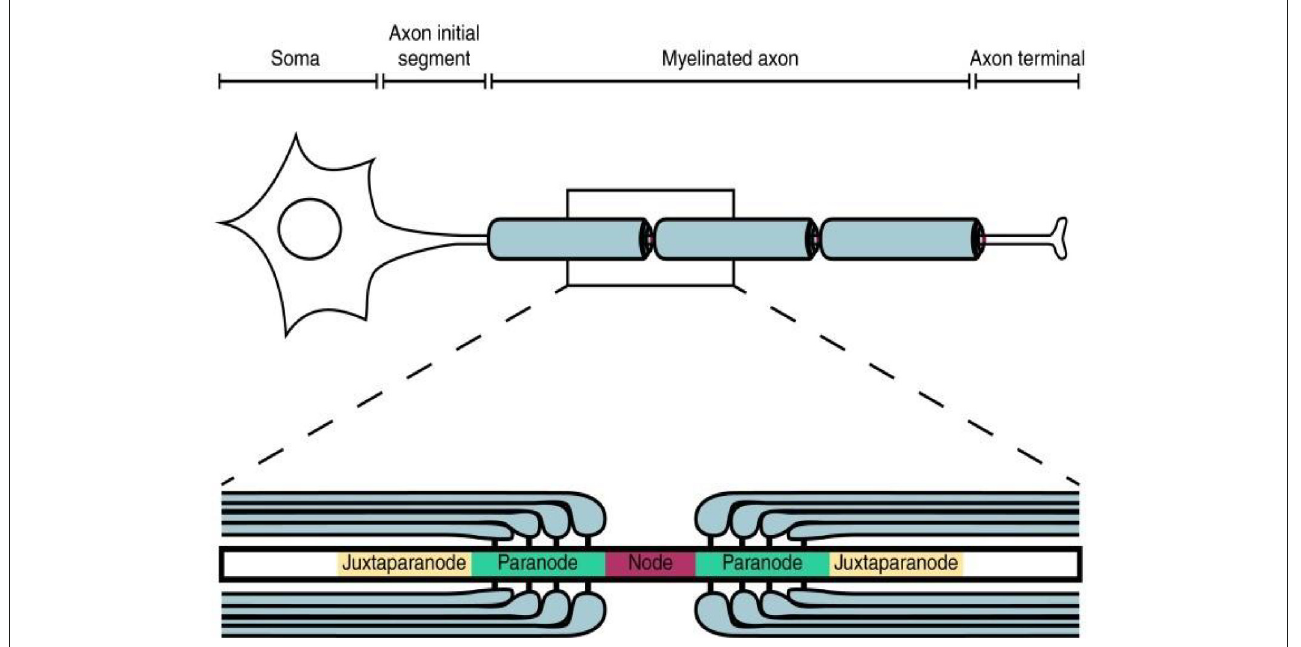
FIGURE2 Nodal, paranodal, and juxtaparanodal regions (Arancibia-Carcamo and Attwell,